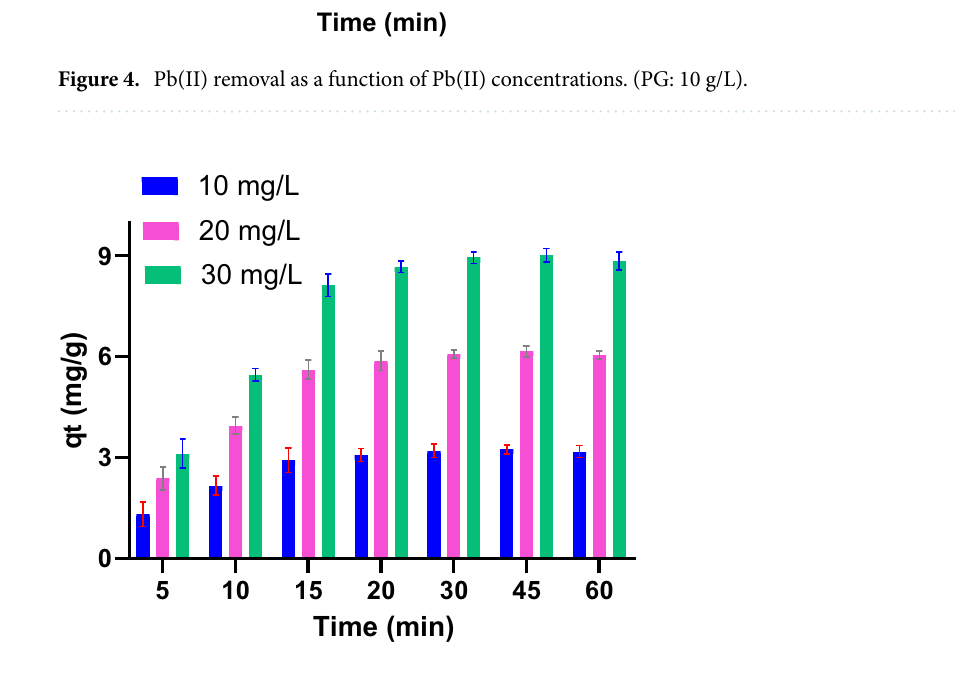
Figure 5. Adsorbent capacity (qt) as a function of Pb(II) concentration (PG: 10 g/L).